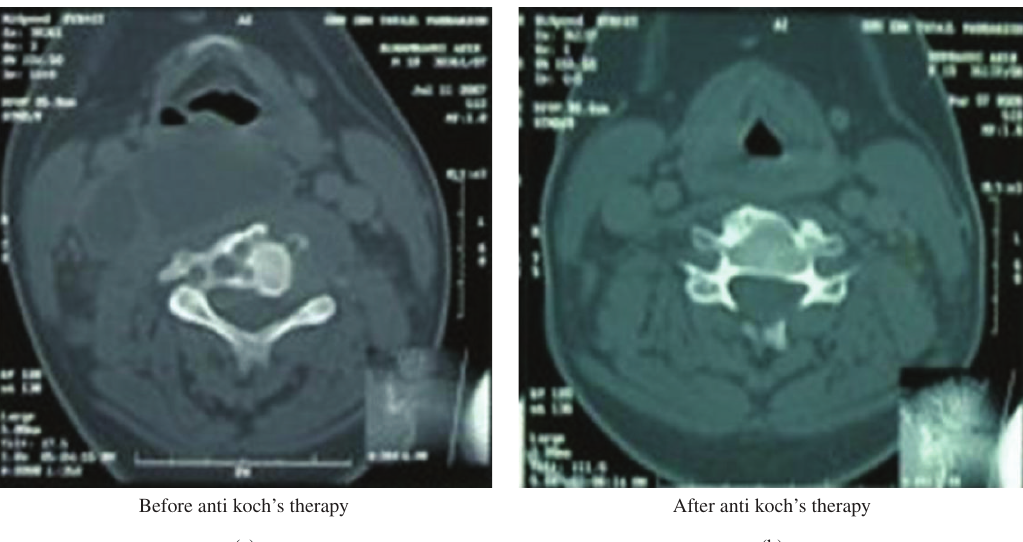
FIGURE 7: Persisting images of bone remodeling after